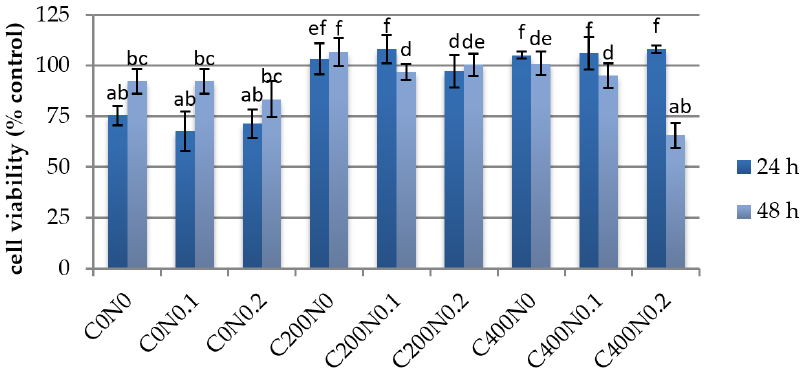
Figure 4. Representative microphotographs of DAPI- staining. RAW264.7 cells were cultured hydrogel materials for 24 h followed by visualization of DNA staining with DAPI using a fluorescence microscope. The data shown are representative of two individual experiments.